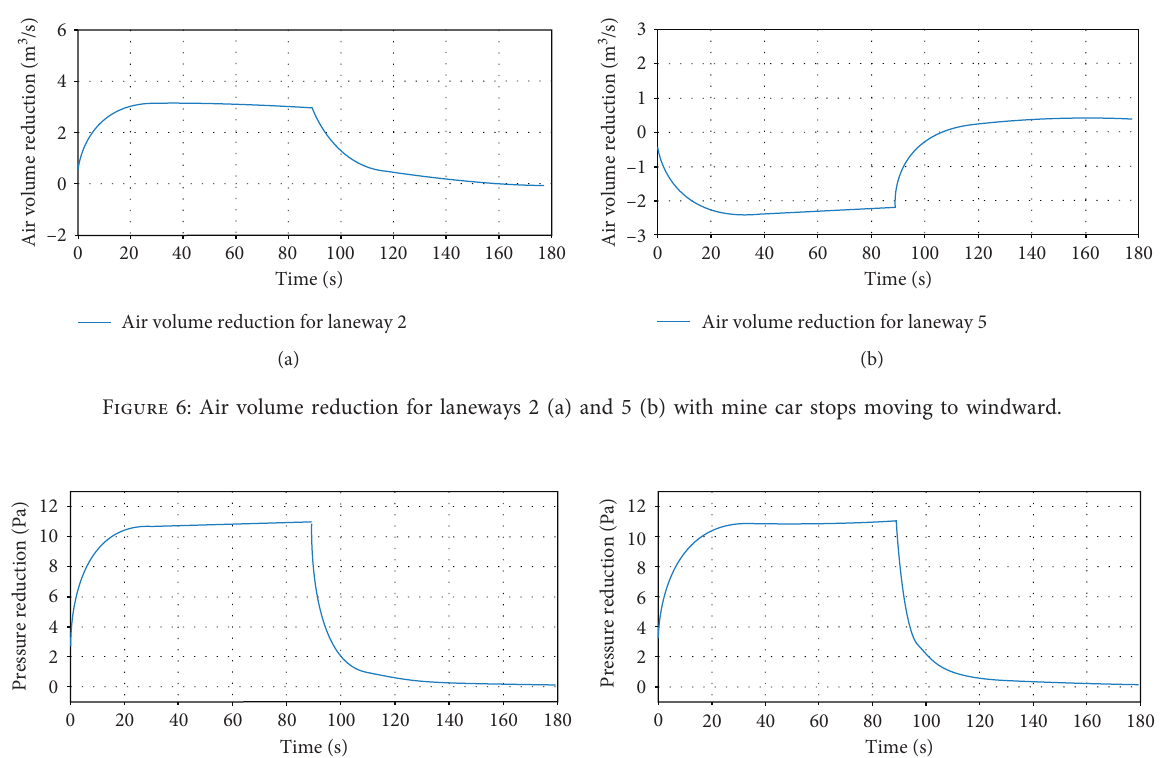
Pressure reduction for node 3 Figure 7: Wind pressure reduction for nodes 3 (a) and 5 (b) with mine car stops moving to